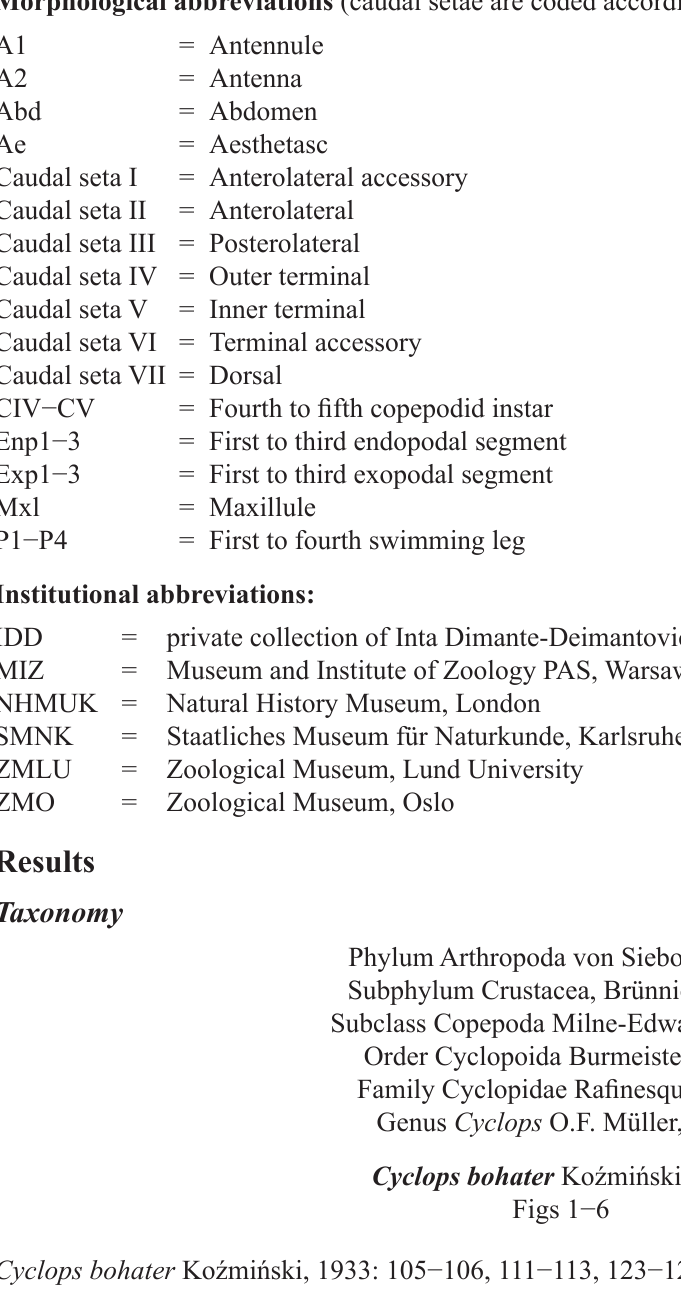
fig. 80; 1996a: 28−31, fig. 18. — ? stanković & ternjej 2007: 189−199, figs 2−12, tab. 2. — Deimantovica 2010 (part) (records from Lake Brigene